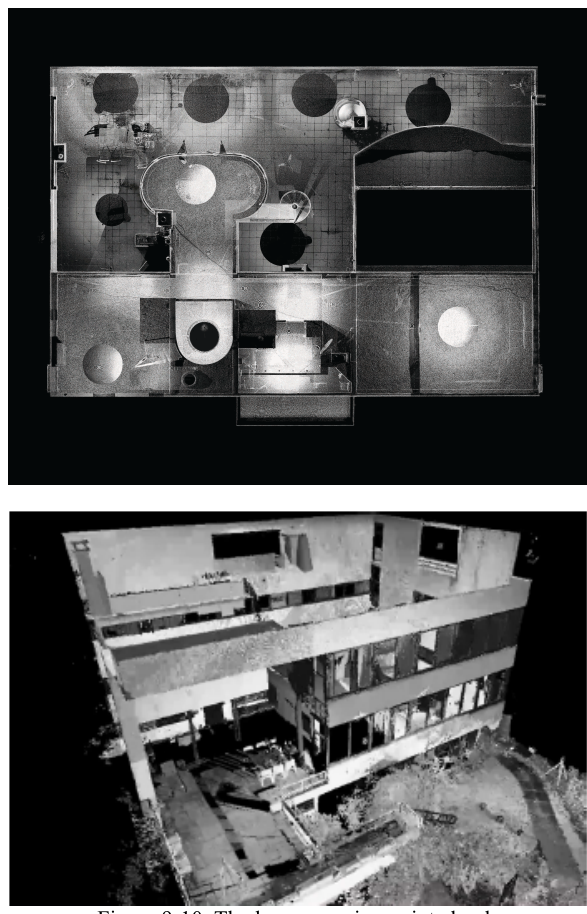
Figure 9-10. The laser scanning point clouds